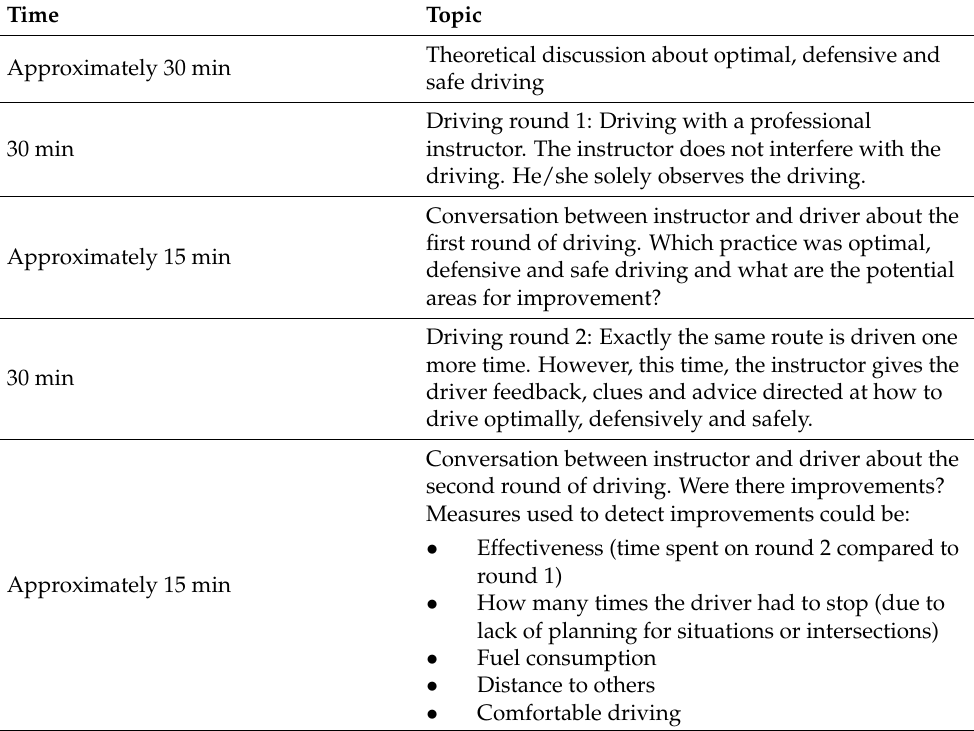
Table 8. Safety training program for HGV